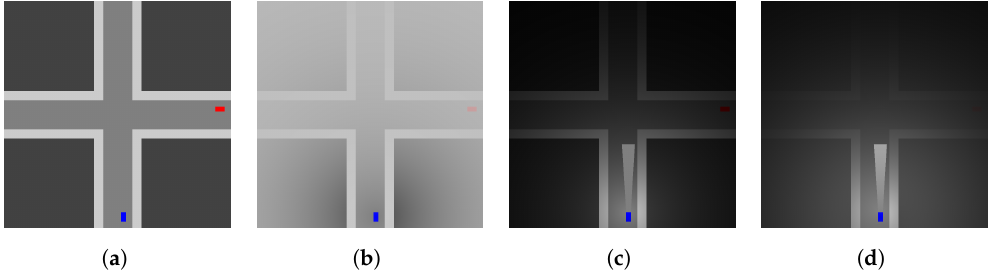
Figure 3. Adverse driving condition contexts (red and blue rectangles representing cars). ( a ) Base case, ( b ) Foggy weather, ( c ) Night/low light, and ( d ) Night with fogginess.